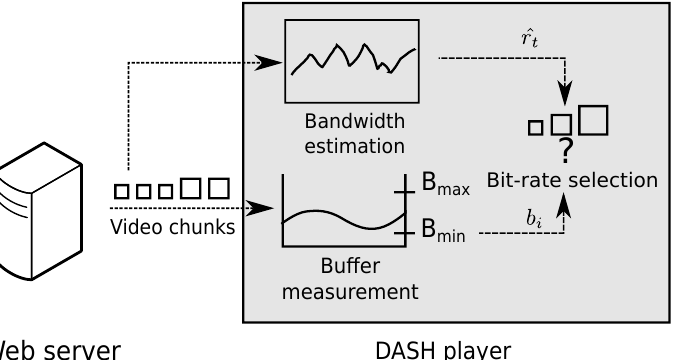
Figure 1. Adaptation strategy for video. A video player chooses the quality of video, taking into account the prediction of network throughput and its buffer